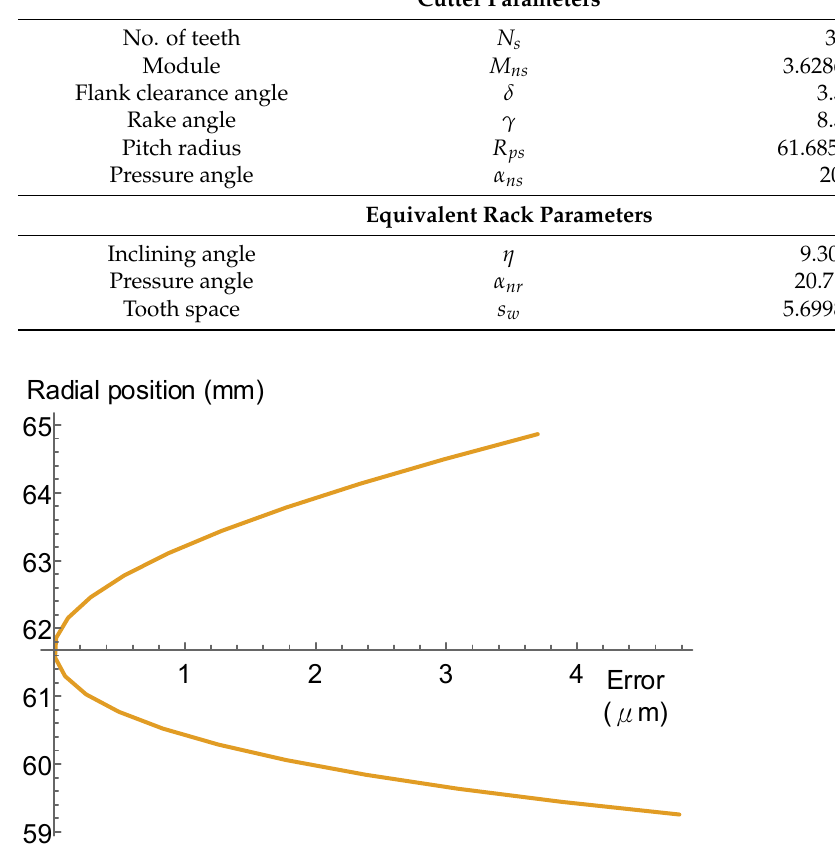
ξ= . Figure 10. Cutter edge profile error of the original case of the cutter face, with ξ = 0.